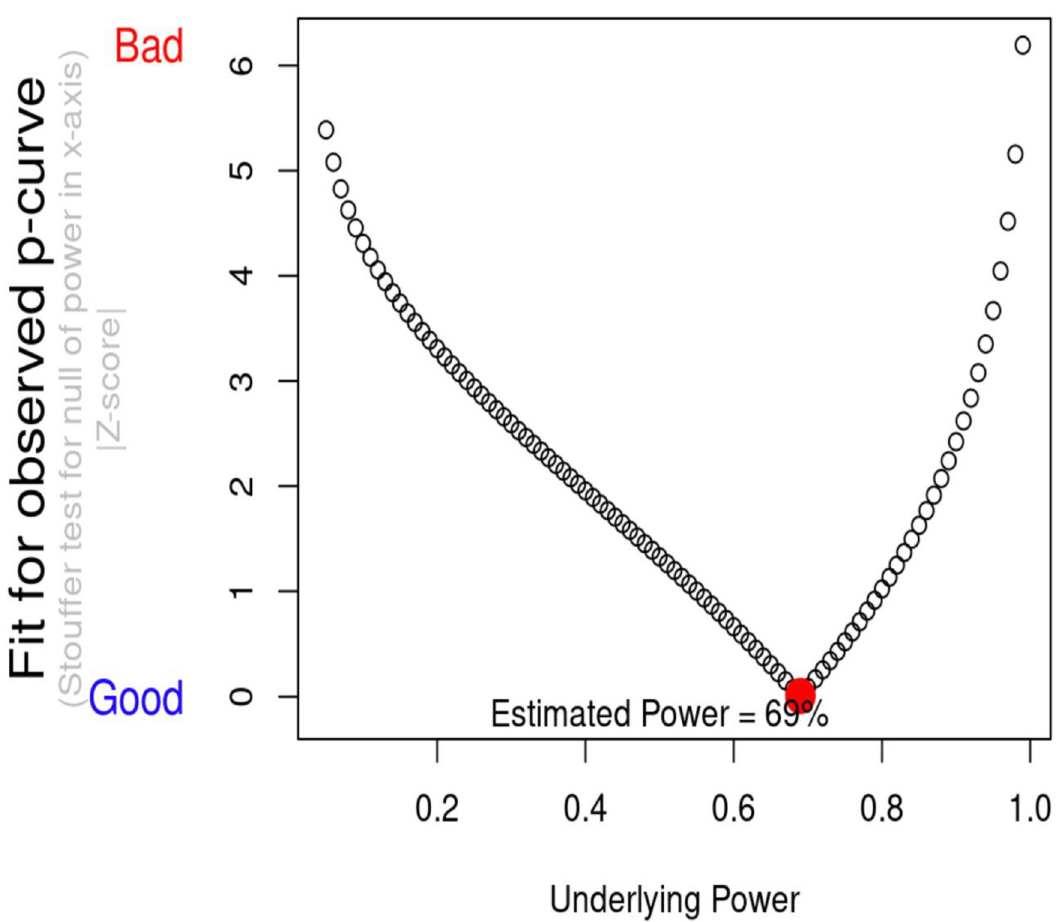
Fig 3. Estimated power of meta-analysis on negative affect and drinking volume.